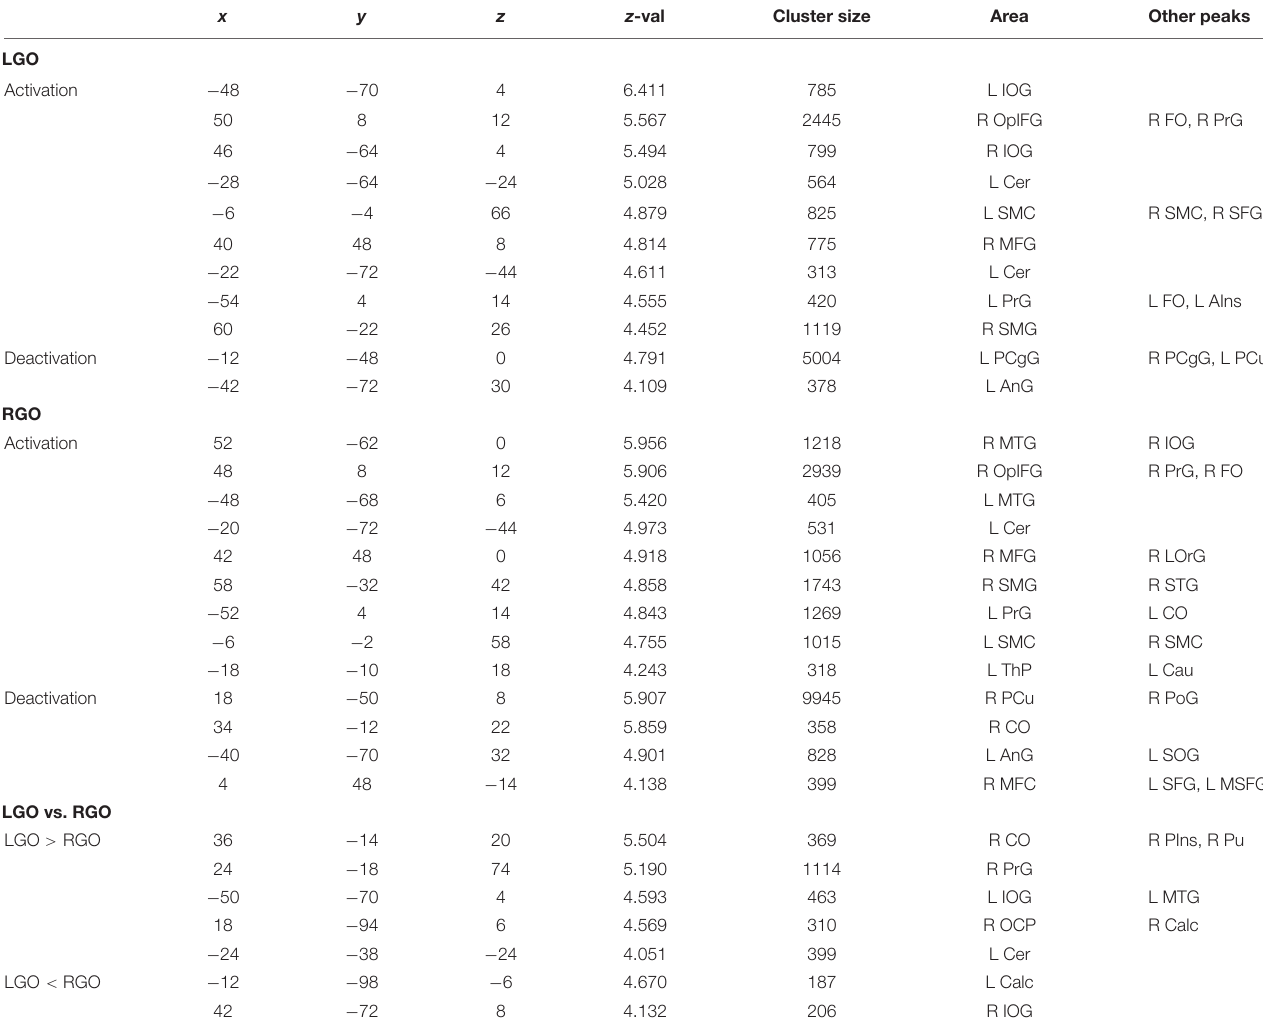
TABLE 4 | Clusters showing significant (FWEc p < 0.05) activation and deactivation during feedback run 3 for the different motor imagery tasks. x y z z -val Cluster size Area Other peaks